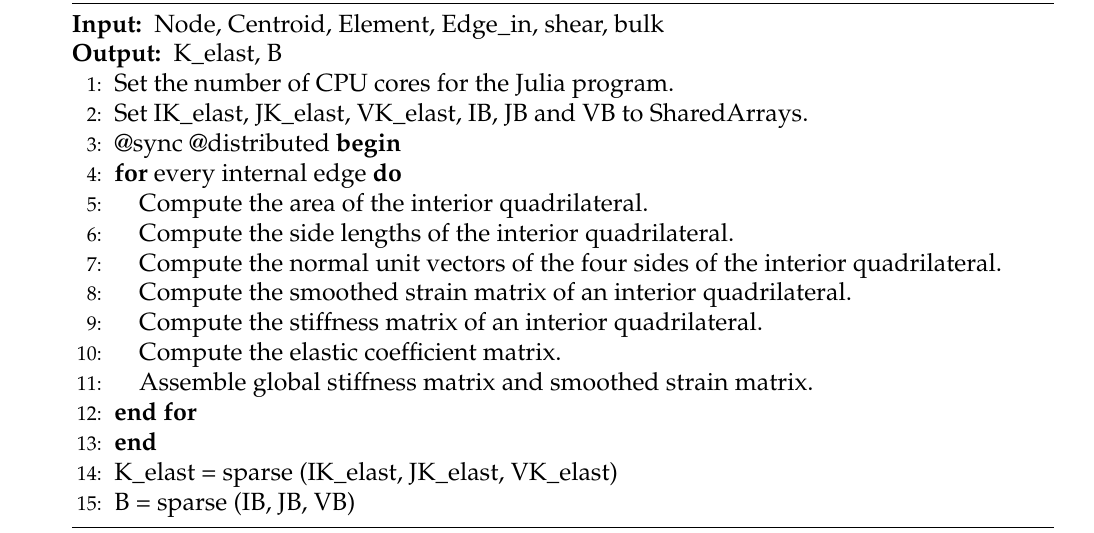
Algorithm 1 Parallel calculation and assembly of the elastic stiffness